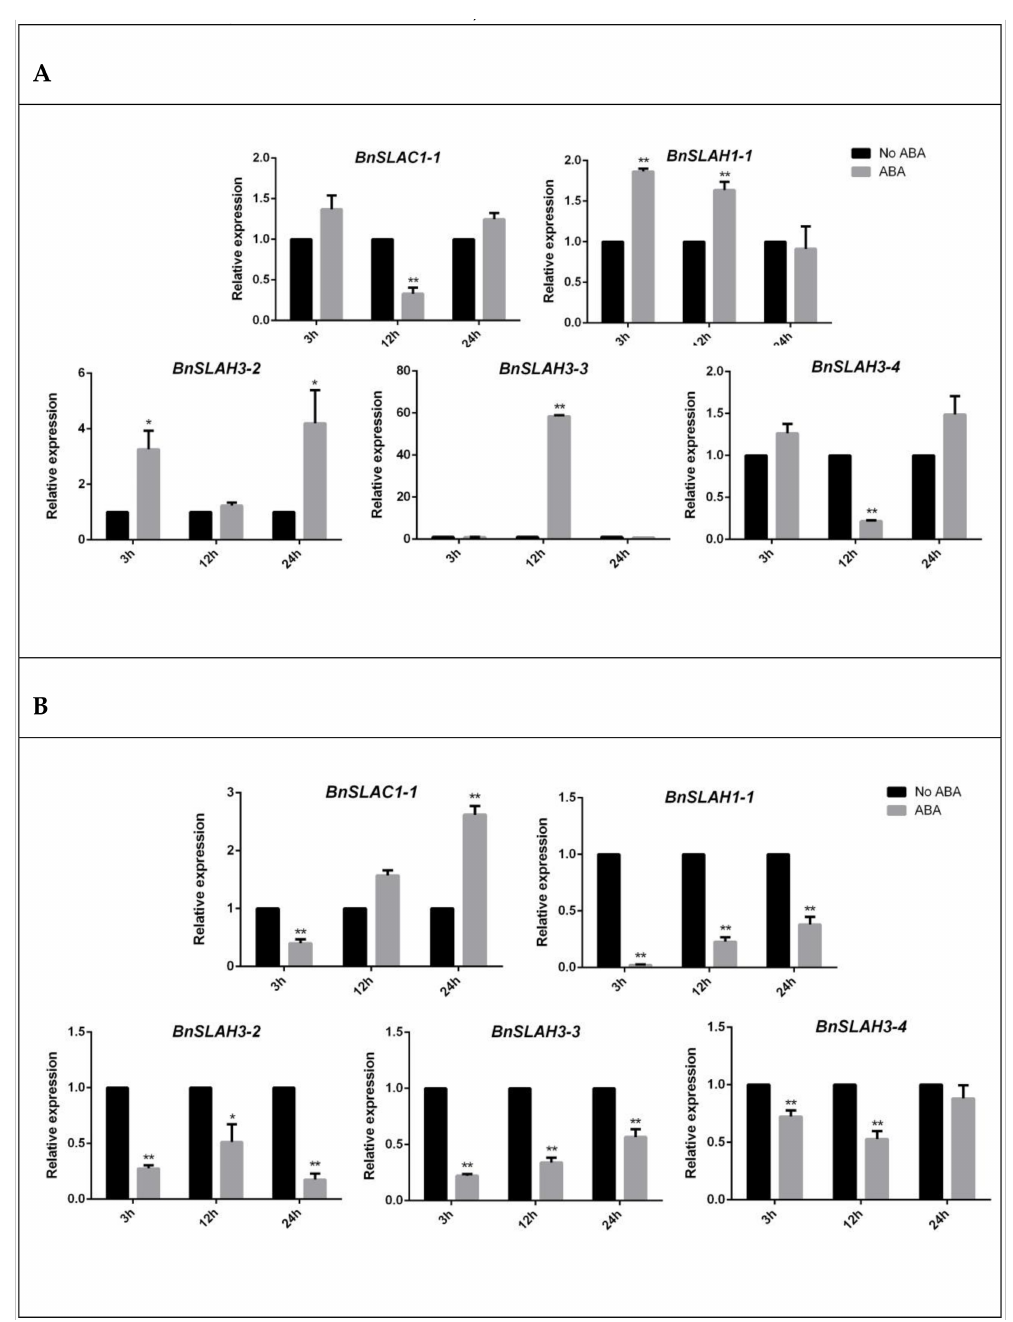
Figure 9. The expression patterns of selected BnSLAC/SLAH genes in leaves ( A ) and roots ( B ) after 3 h, 12 h and 24 h ABA (100 uM) treatment. The asterisk represents statistical significance (Student’s t -test, “*” p < 0.05, “**” p < 0.01) in comparison with control. The data are shown as mean values ± SE ( n =